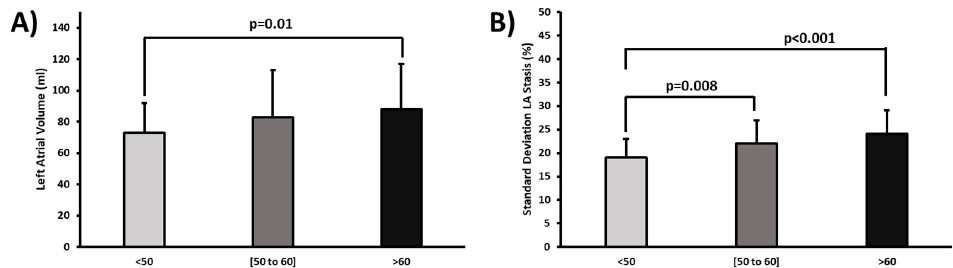
Figure 3. Age comparison for left atrial volume and standard deviation stasis. Panel ( A ) shows the comparison of age groups for left atrial (LA) volume. Panel ( B ) indicates the comparison of age groups for standard deviation LA stasis.